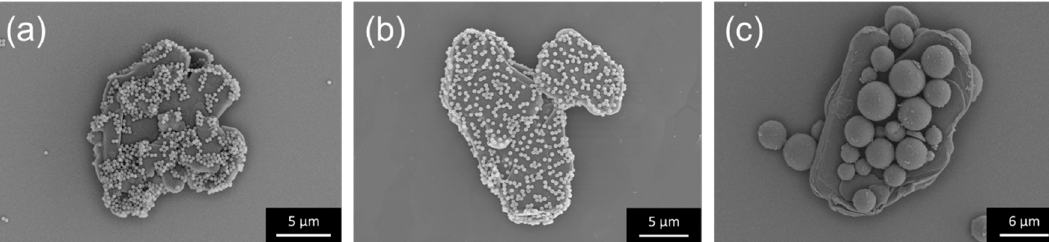
Figure 3. SEM images of the PMMA / hBN (hBN core) composite particles obtained after electrostatic assembly, using various combinations: ( a ) 0.3- µ m PMMA on 5- µ m hBN sheets, ( b ) 0.3- µ m PMMA on 18- µ m hBN sheets, and ( c ) 5- µ m PMMA on 18- µ m hBN sheets.